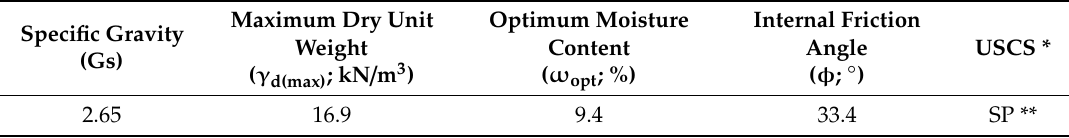
Table 1. Engineering properties of Jumunjin standard sand in Korea.